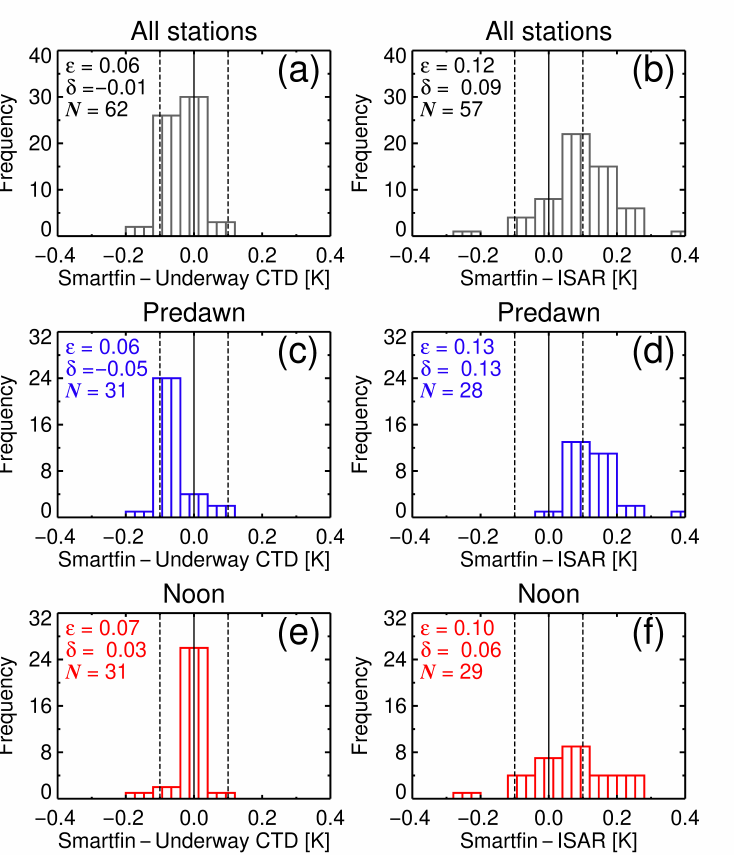
Figure 4. Histrograms of the differences in SST between sensors on the Atlantic Meridional Transect cruise 28. ( a ) Differences between the Smartfin and underway CTD. ( b ) Differences between the Smartfin and ISAR. ( c ) Differences between the Smartfin and underway CTD for predawn stations only. ( d ) Differences between the Smartfin and ISAR for predawn stations only. ( e ) Differences between the Smartfin and underway CTD for noon stations only. ( f ) Differences between the Smartfin and ISAR for noon stations only. Note for ( a , e ) one station is not shown (off the scale) where a difference between the Smartfin and underway CTD of 1.21K was observed (see Figures 3b and 5a). The mean difference ( δ ) and mean absolute difference ( (cid:101) ) between Smartfin and the ISAR were 0.09 and 0.12 K respectively (Figure 4b, Table 1). Overall, the Smartfin data